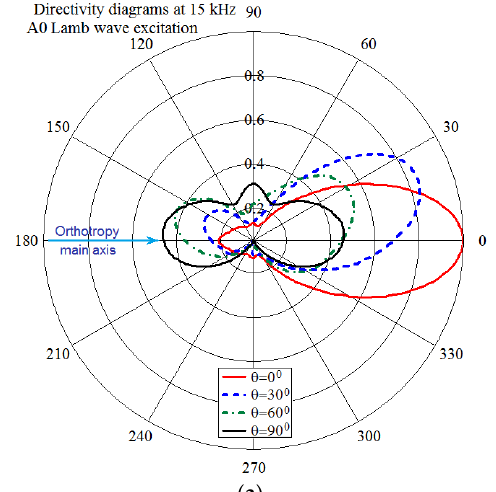
Figure 10. The directivity diagrams of the A0 Lamb waves propagating at the different